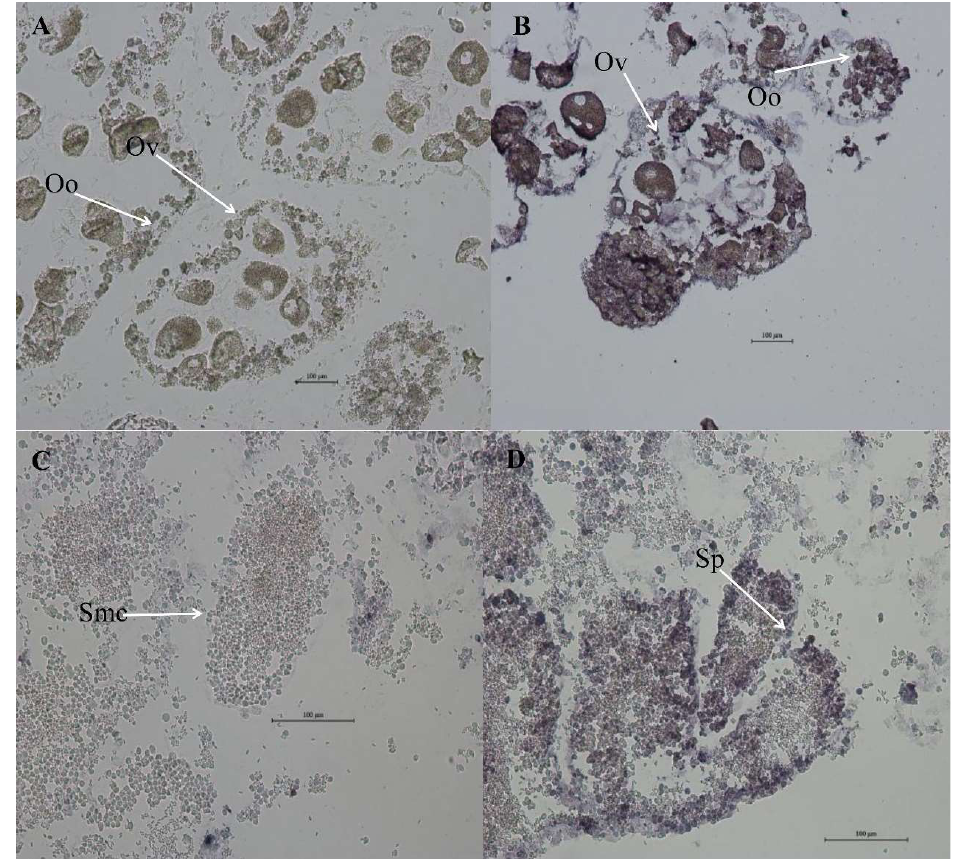
Figure 7. MK2 in situ hybridization in 1-year-old H. cumingii gonads . ( A ) Female-negative control group ( B ) Female experimental group ( C ) Male-negative control group ( D ) Male experimental group (Ov: Ovum; Oo: Oocyte; Smc: Spermatocyte; Sp: Sperm).